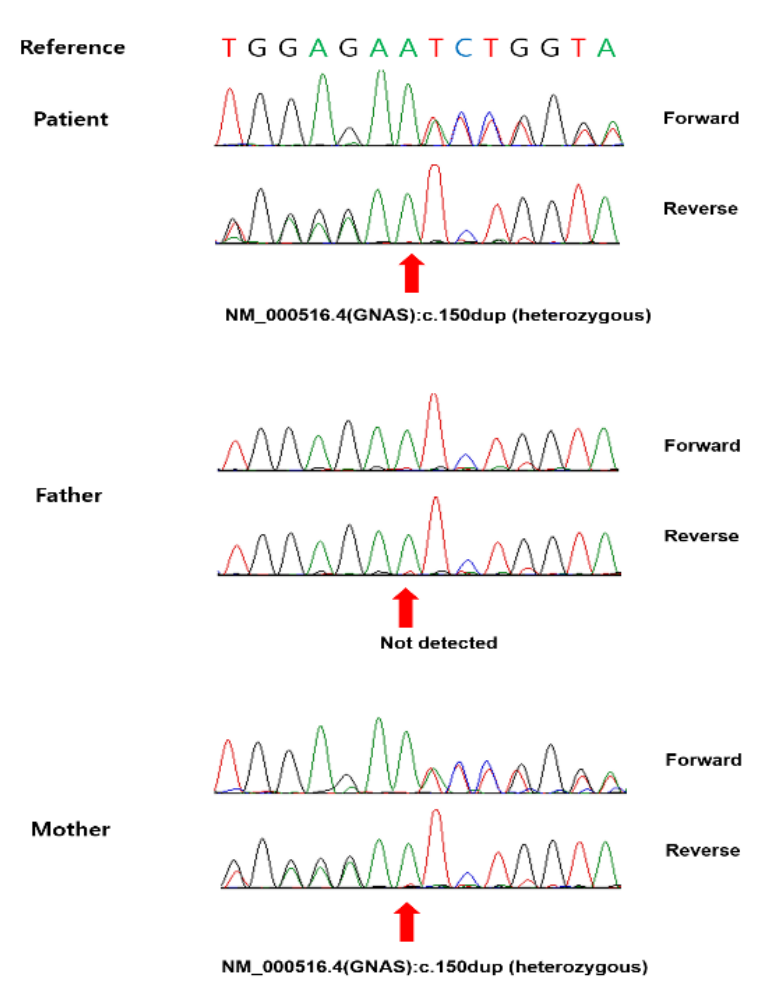
Figure 2. Genetic testing of the family. The patient harbored a c.150dupA (p.Ser51Ilefs*3) mutation (red arrow) inherited from her mother.